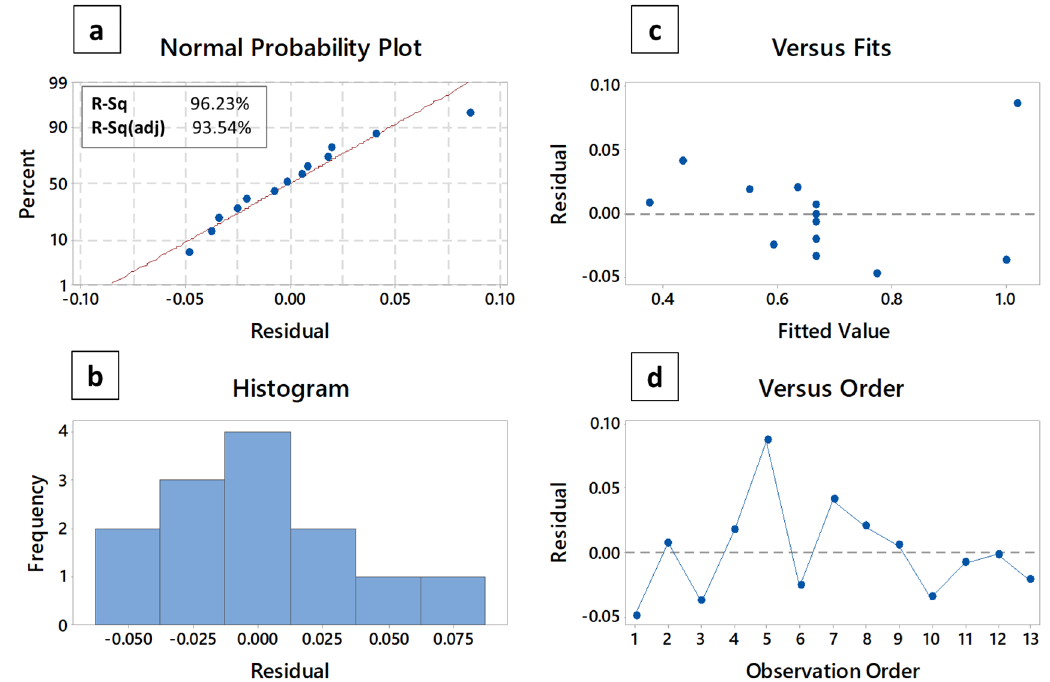
Figure 5. Residual plots for the thermal conductivity of the nanocomposites: ( a ) normal probability plot with residuals (blue dots) vs. ideal normal distribution (red line), ( b ) the histogram of residuals plot, ( c ) the residuals (blue dots) vs. fits (blue dashed line) plot, and ( d ) the residuals (blue dots) vs. order of data (blue dashed line) plot.